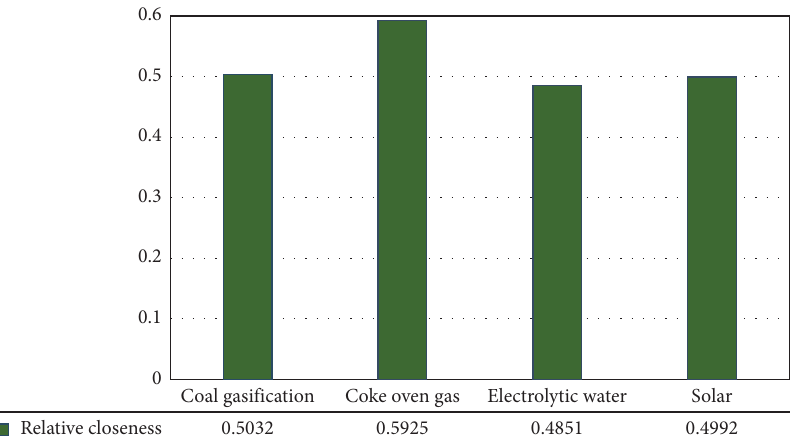
Figure 2: Relative closeness of comprehensive evaluation of hydrogen production